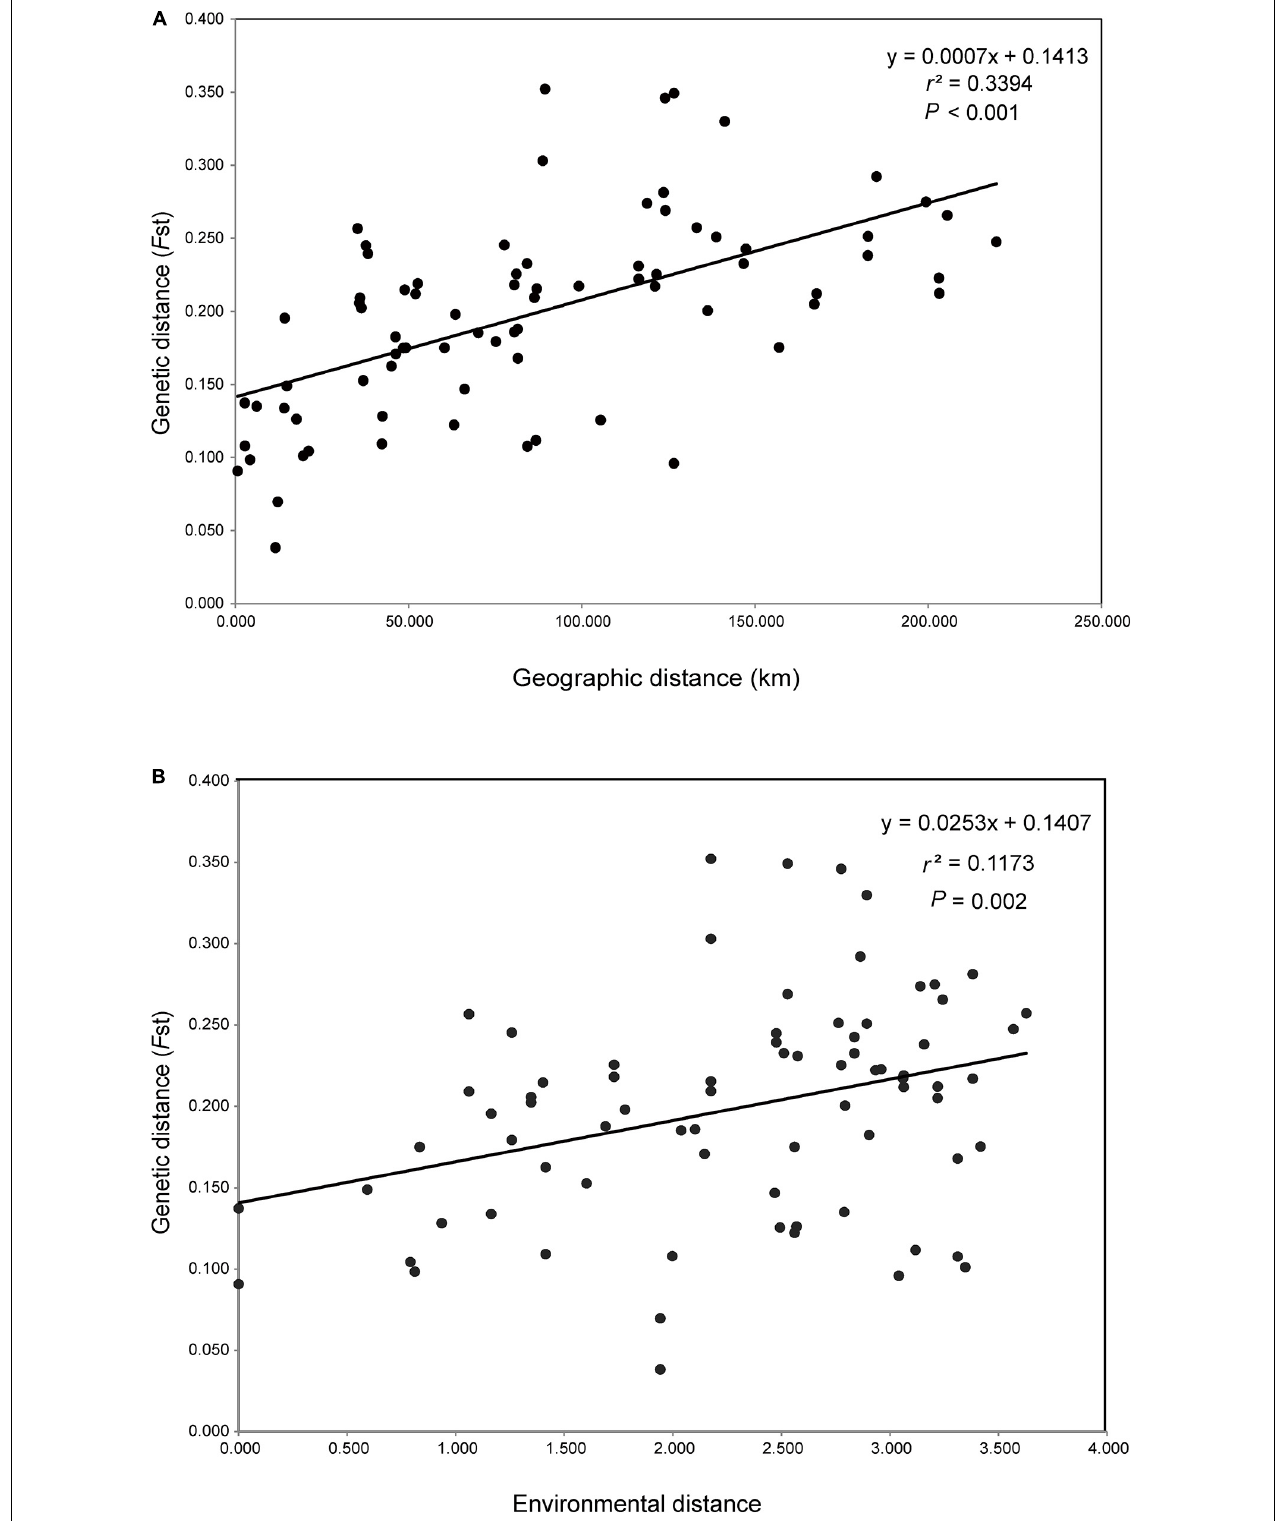
FIGURE 4 | Mantel tests of geographic, environmental, and genetic correlations. (A) Correlation of pairwise geographic distance versus pairwise genetic distance ( F ST ); (B) correlation of pairwise environmental distance versus pairwise F ST .